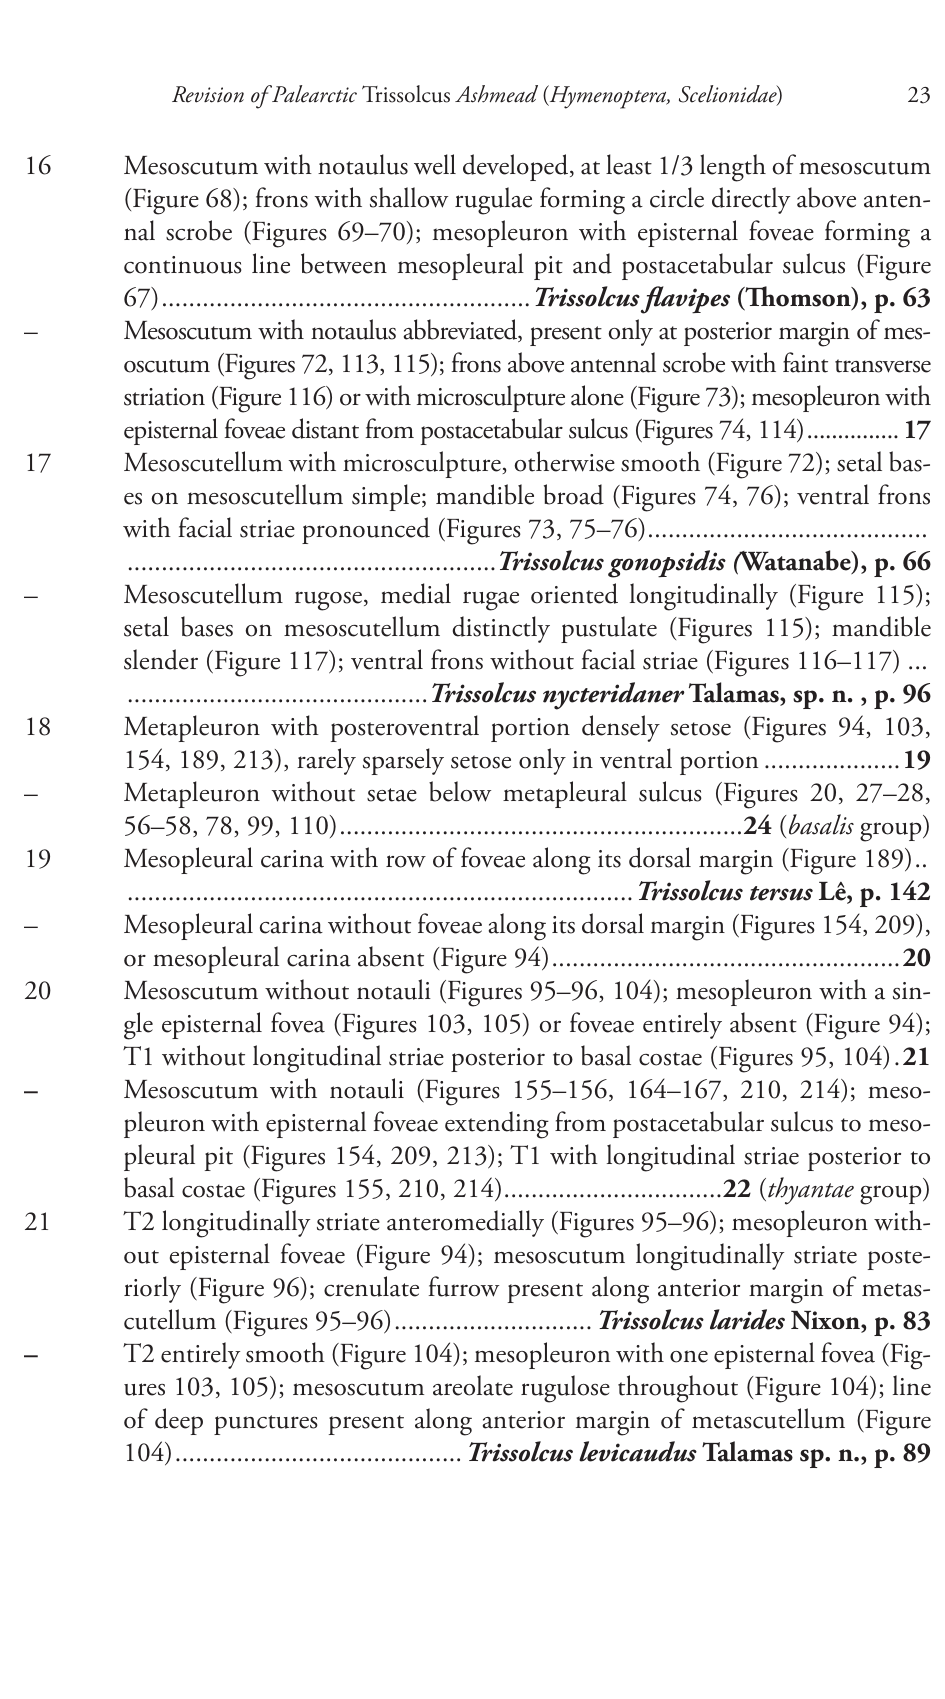
Mesoscutum with notaulus well developed, at least 1/3 length of mesoscutum (Figure 68); frons with shallow rugulae forming a circle directly above anten- nal scrobe (Figures 69–70); mesopleuron with episternal foveae forming a continuous line between mesopleural pit and postacetabular sulcus